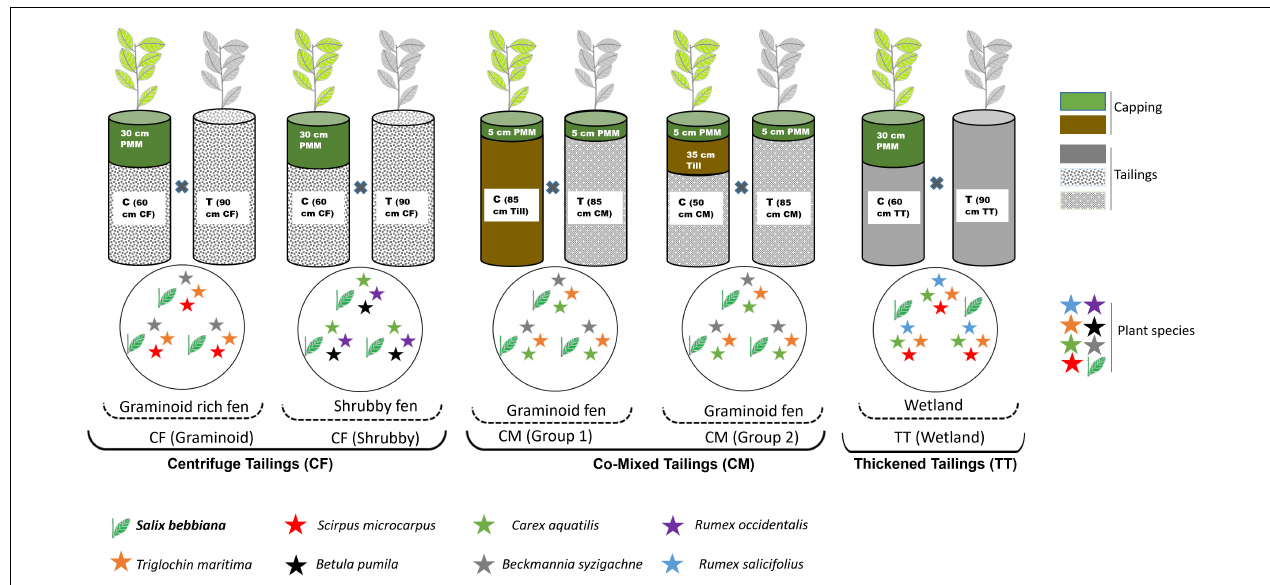
FIGURE 1 | Diagram of experimental design in which willow ( Salix bebbiana ) was grown in different types of oil sand tailings (with or without capping of different depths) along with various plant communities. Gray plants represent the signs of OST-related stress (i.e., columns covered with no reclamation cap or 5 cm of reclamation cap) and green plants represent no sign of stress (i.e., columns with ≥ 30 cm of reclamation cap). Four columns were assembled for each treatment ( n = 4). T, treatment; C, control; CF, centrifuge tailings; CM, co-mix tailings; TT, thickened tailings; PMM, peat mineral mix; Till, mineral substrate (classified as sandy clay loam soil with low organic